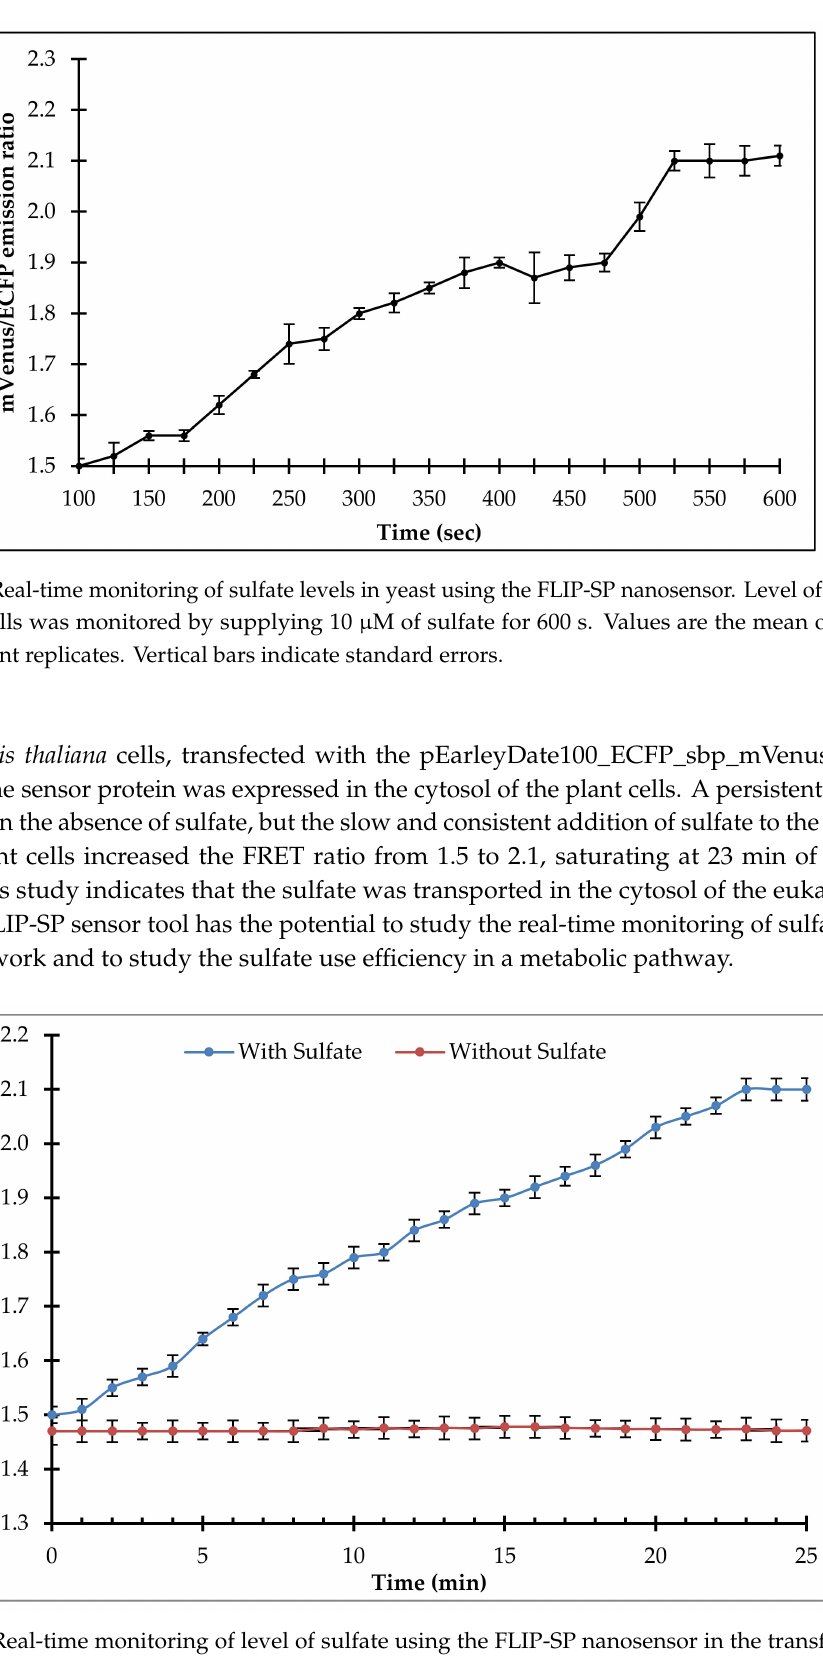
Figure 9. Real-time monitoring of level of sulfate using the FLIP-SP nanosensor in the transformed Arabidopsis thaliana cells in the absence and presence of